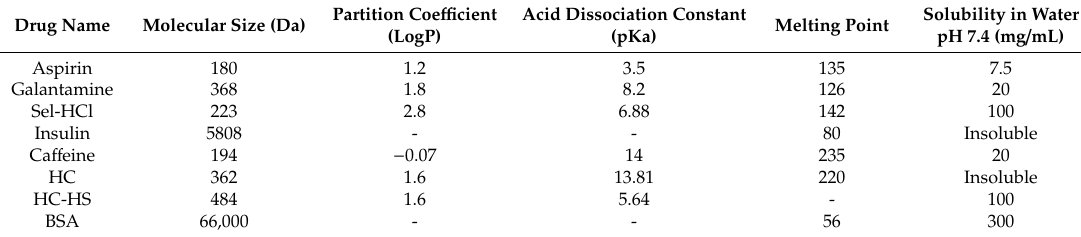
Table 1. Physicochemical characteristics of mosaic